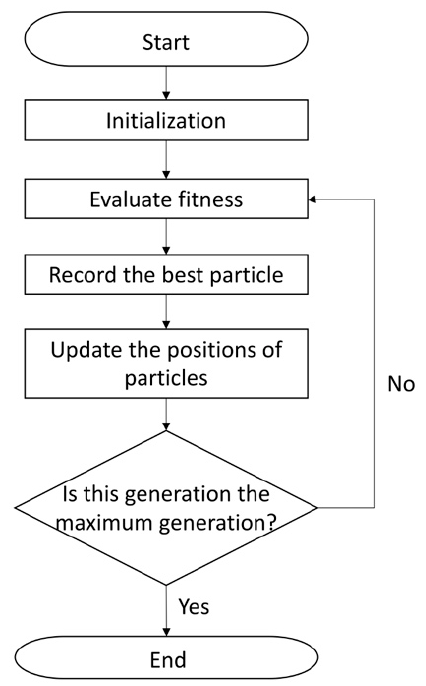
Figure 5. Flowchart of the particle swarm optimization.